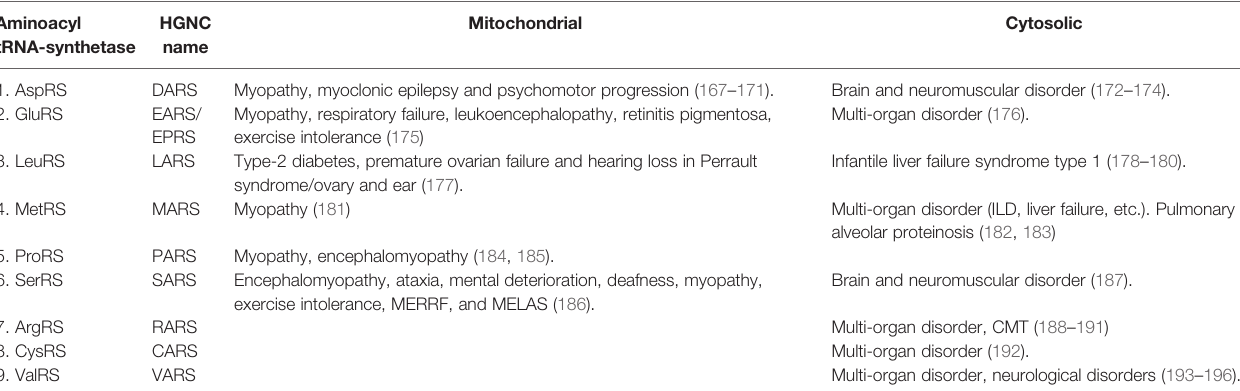
TABLE 4 | Mutations in genes encoding mitochondrial or cytosolic aaRSs and associated disorders